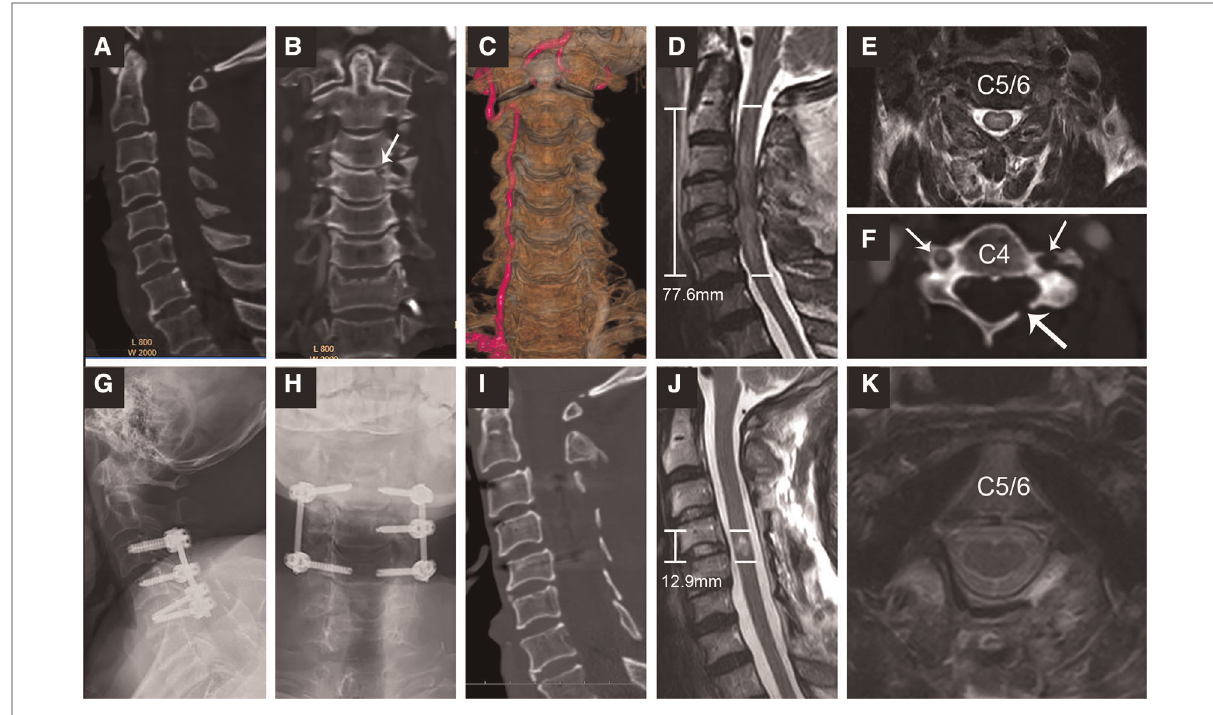
FIGURE 2 Representational preoperative ( A – F ) and postoperative ( G – K ) images of a 68-year-old male patient who sustained an A1 type fracture and spinal cord injury. His AMS was 11 and AIS grade B. Midsagittal ( A ), coronal ( B,C ) and axial ( F ) enhanced CT indicated an A1 type fracture at C4 ( B ) accompanied by fractures of the left lamina ( F , long arrow) and transverse foramen (short arrow) and injury to the left vertebral artery ( C ). MRI ( D,E ) showed SCI with an intramedullary lesion length (IMLL) of 77.6 mm. The subarachnoid space (SAS) was absent from C3 to C5 ( D ). Laminoplasty of C3 – 7 and pedicle screw fi xation from C3 – C5 were performed in this patient 9 h after trauma. Postoperative x-rays ( G,H ) and CT ( I ) showed good screw positioning and signi fi cant enlargement of the osseous spinal canal. Postoperative MRI indicated an IMLL of 12.9 mm ( J ), successful decompression ( J ), and reduced edema 12 days after trauma. One year after injury, the patient paralysis recovery with an AMS of 72 and AIS grade D